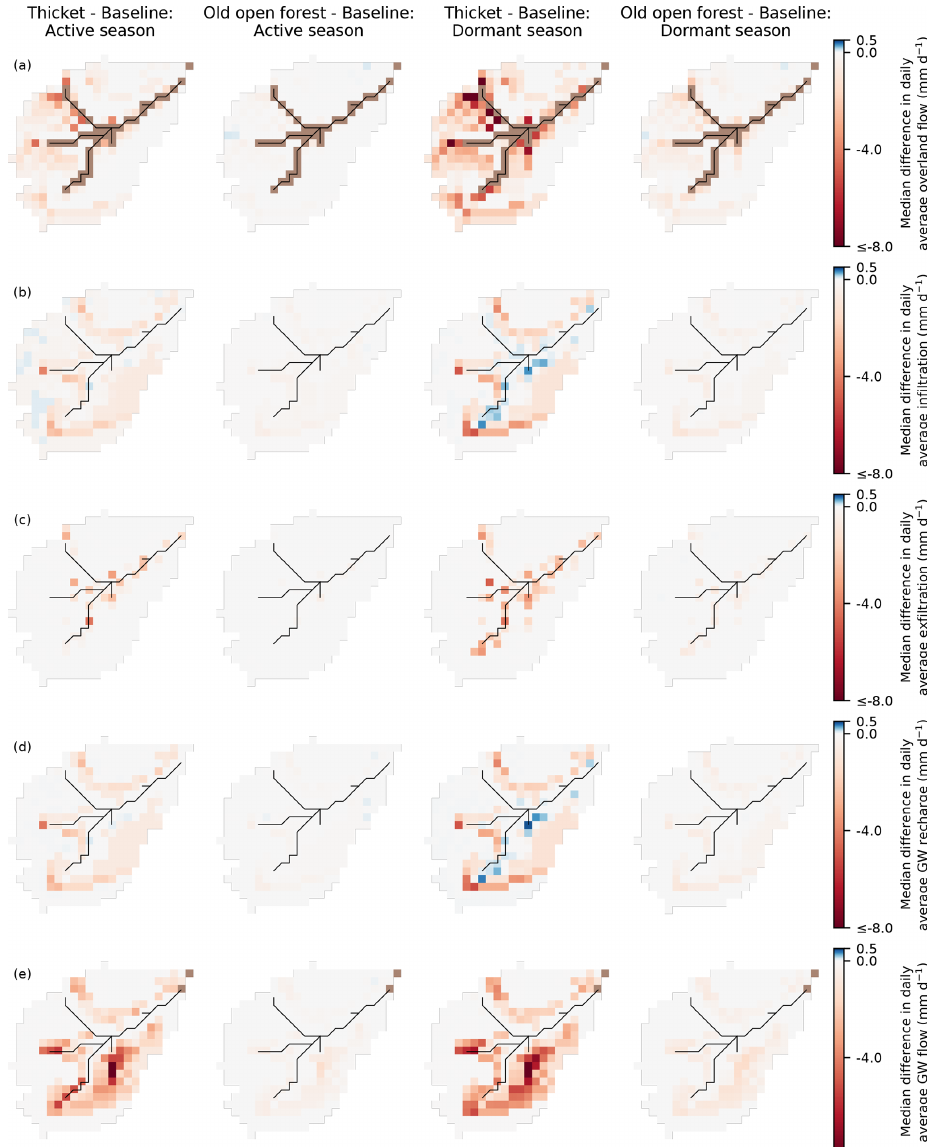
Figure 7. Maps showing the median difference in daily average blue fluxes for the active (April to September) and dormant (October to March) seasons. (a) Cell-to-cell overland flow. (b) Infiltration into the first soil layer (L1). (c) Exfiltration to the surface. (d) Groundwater (GW) recharge. (e) Cell-to-cell lateral GW flow. Differences are reported as the regeneration scenario minus baseline scenario. Brown cells in panels (a) and (e) are cells for which EcH 2 O-iso does not simulate cell-to-cell overland (channel and outlet cells) and lateral GW flows (outlet cells). Colour bar is truncated at the lower limit to aid in the presentation of spatial patterns (largest negative difference is − 9 . 7mmd − 1 for overland